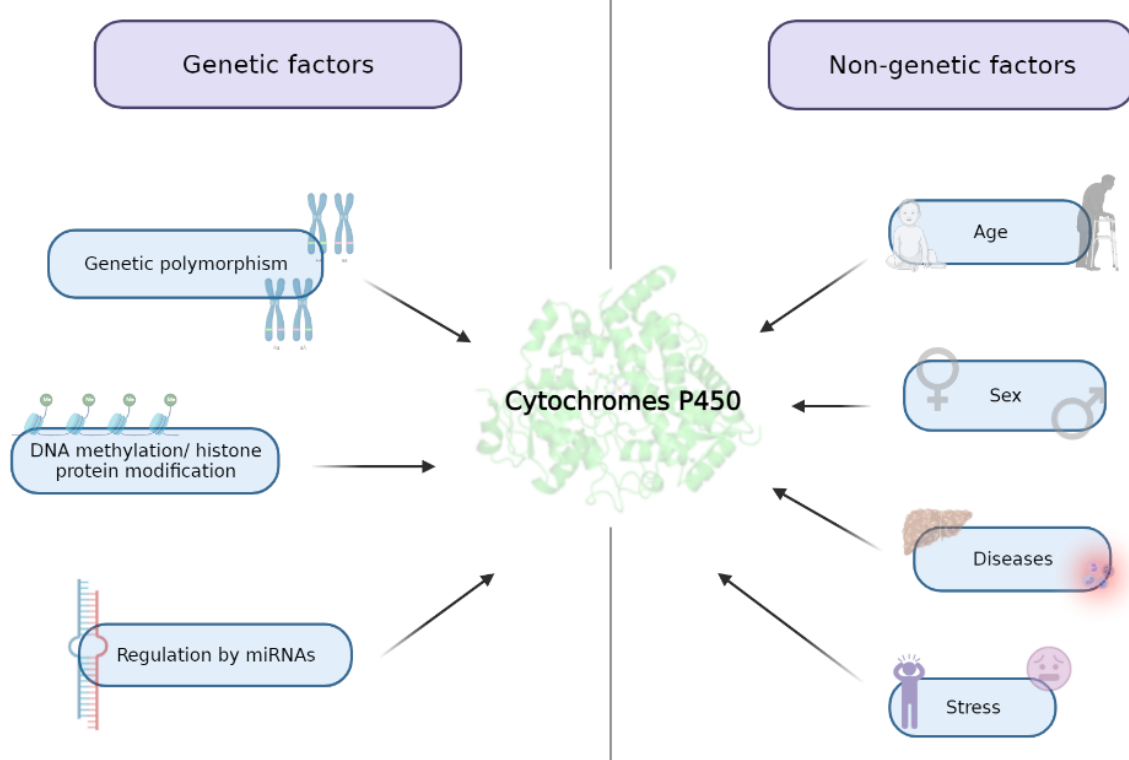
Fig. 2. Factors influencing cytochromes P450. Genetic and non-genetic factors are able to influence the expression and function of various cytochromes P450. Genetic factors include genetic polymorphism and epigenetic processes such as DNA methylation, histone protein modification, and regulation by microRNAs (miRNAs). Non-genetic factors include age, sex, various diseases and also stress. (Created with